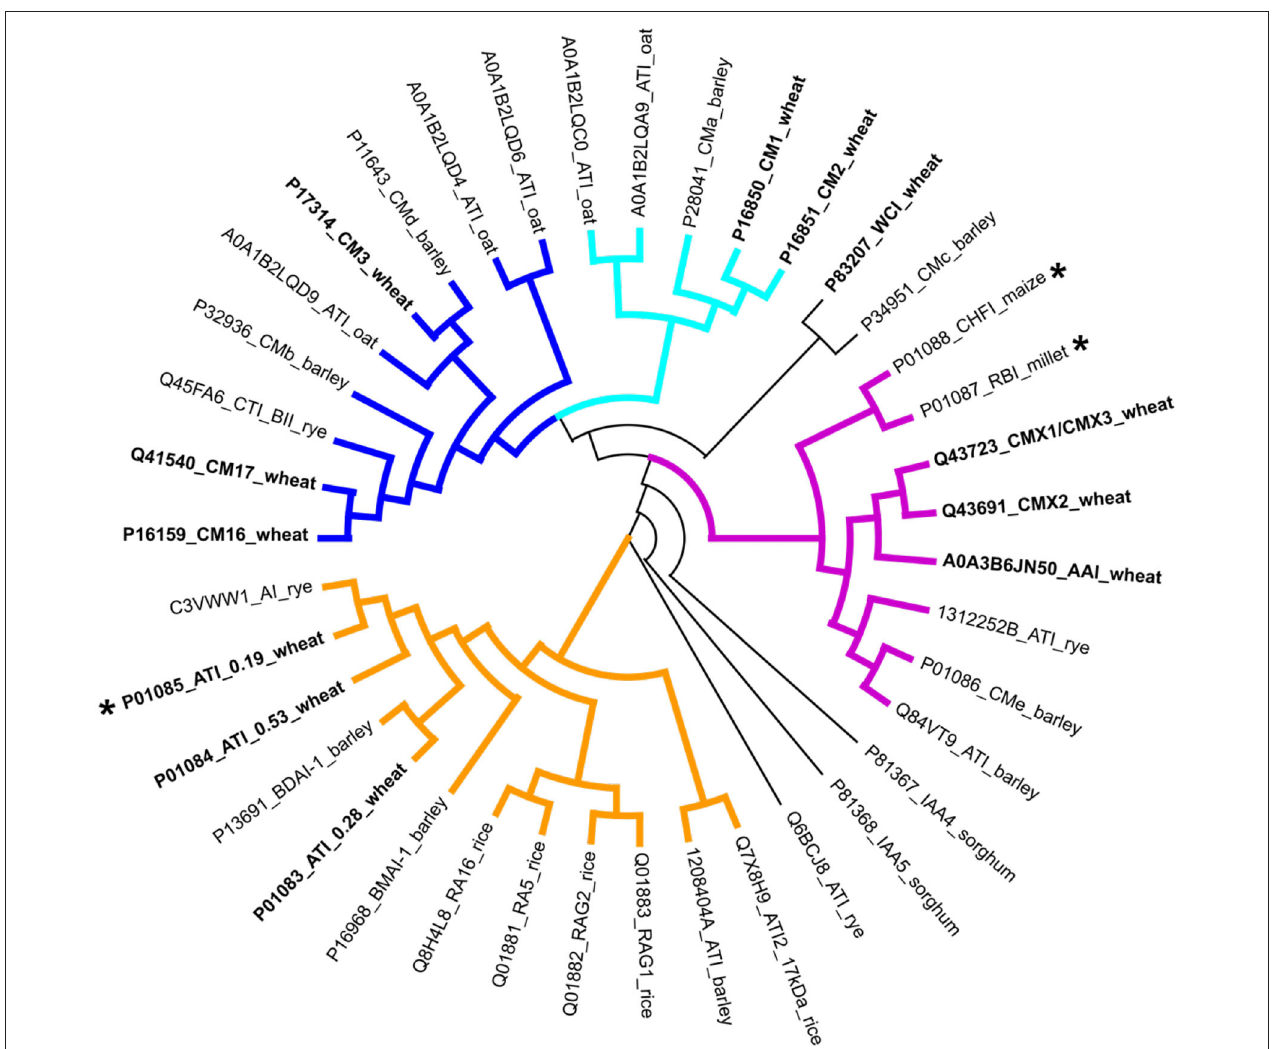
FIGURE 3 | Phylogenetic analysis of ATIs in cereal species with wheat ATIs shown in bold. The sequence conservation of the ATIs is very low, but comparison of the three ATIs for which 3D structures have been determined (indicated by stars) shows that structural conservation is high. The coloring of the subgroups follows that used in Figure 1 : blue and cyan, heterotetrameric; purple, trypsin/bifunctional inhibitors; orange, monomeric and homodimeric). Software used: MEGA X (12) (Muscle for alignment preparation and Maximum likelihood for phylogeny analysis), and Dendroscope (